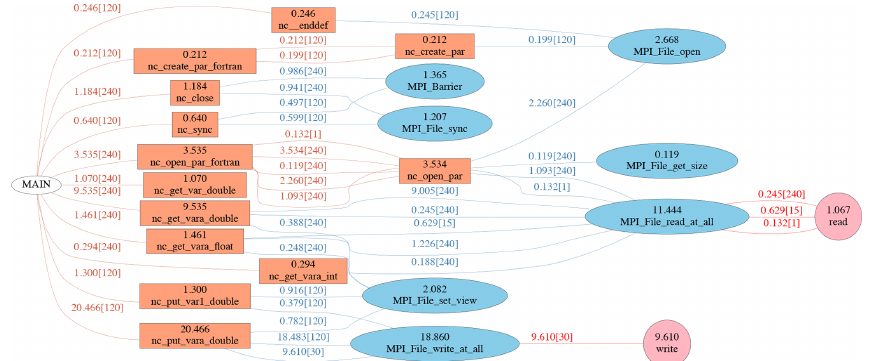
Figure 12. The call path flow of tuned 240 PE benchmark with PnetCDF. It is classified into three layers, i.e. netCDF, MPI-IO and system I / O functions. The maximum PE time together with the total number of PEs from the invoker are labelled above each path line, and the maximum PE time on each function are labelled within the node